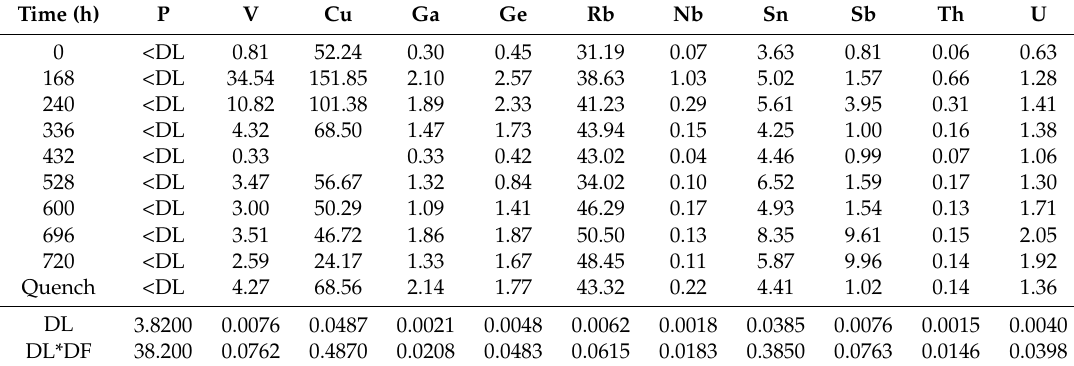
Table 4. Water chemistry sampled during the cap-rock reaction, with dissolved element concentrations ( µ g/kg), and the associated detection limit (DL) and effective detection limit multiplied by the dilution factor (DL*DF). <DL indicated the measurement was below detection. Quench refers to the residual fluid in the reactor after depressurization. The associated error for the analyses by ICP-MS is